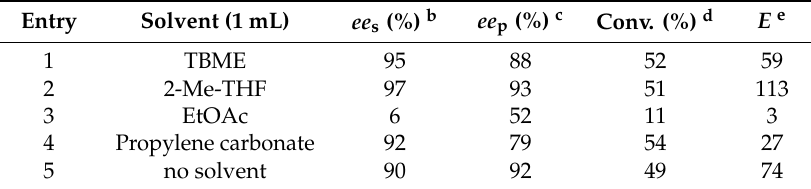
Table 1. Solvent screening in the hydrolysis of ( ± )-3 a a .